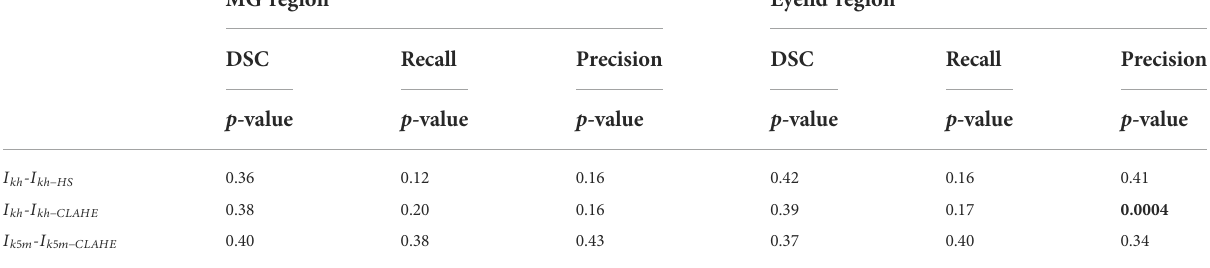
TABLE 3 Comparison between segmentation results of different preprocessing